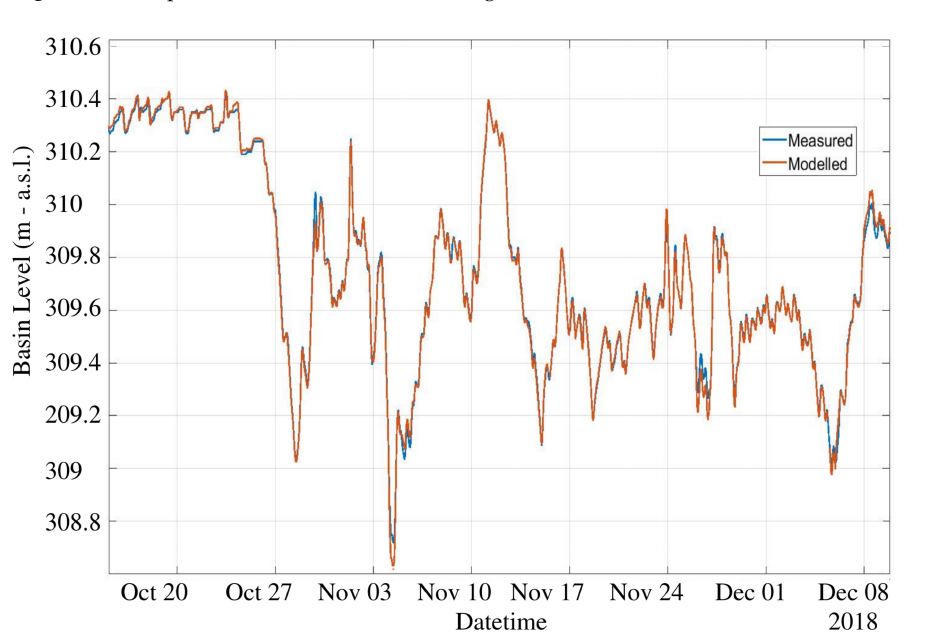
Figure 13. Predicted level during test period, comparison between NARX model and measured for h = 1 h ahead. MAE is 2